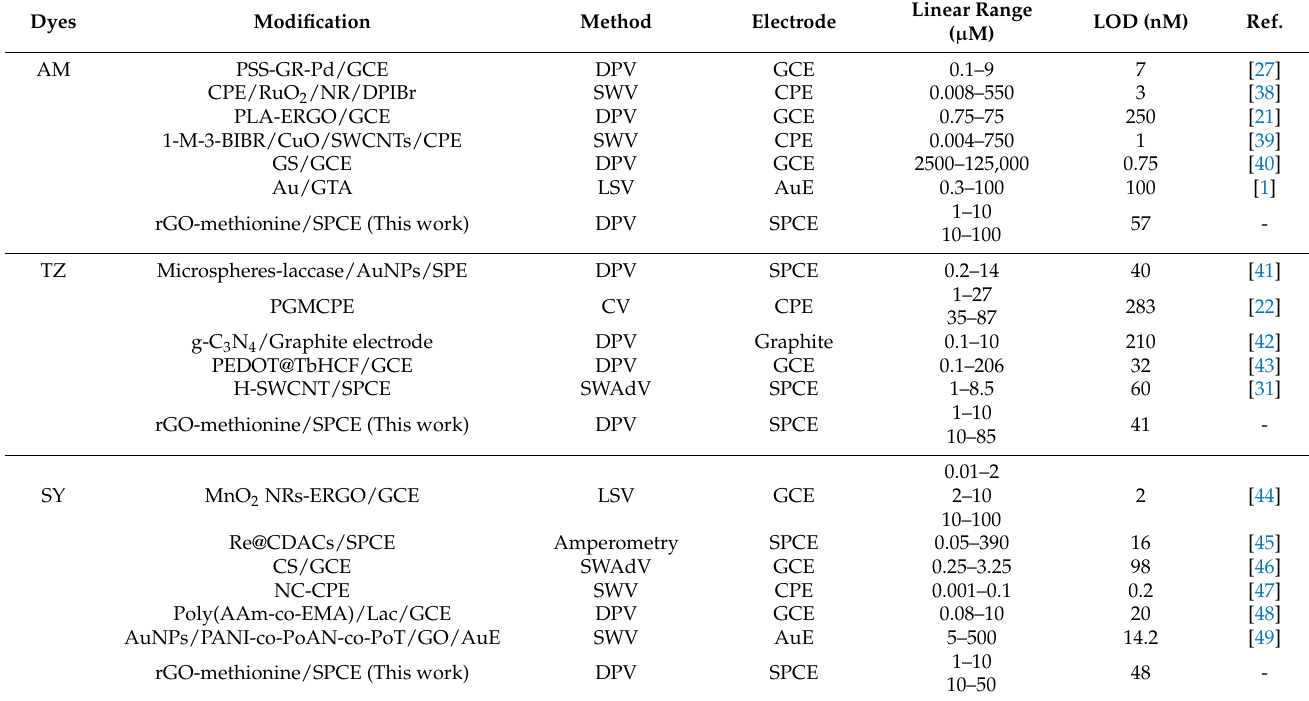
Table 2. Comparison of the analytical performance between the developed sensor and previous electrochemical sensors of amaranth, tartrazine, sunset yellow, and carminic